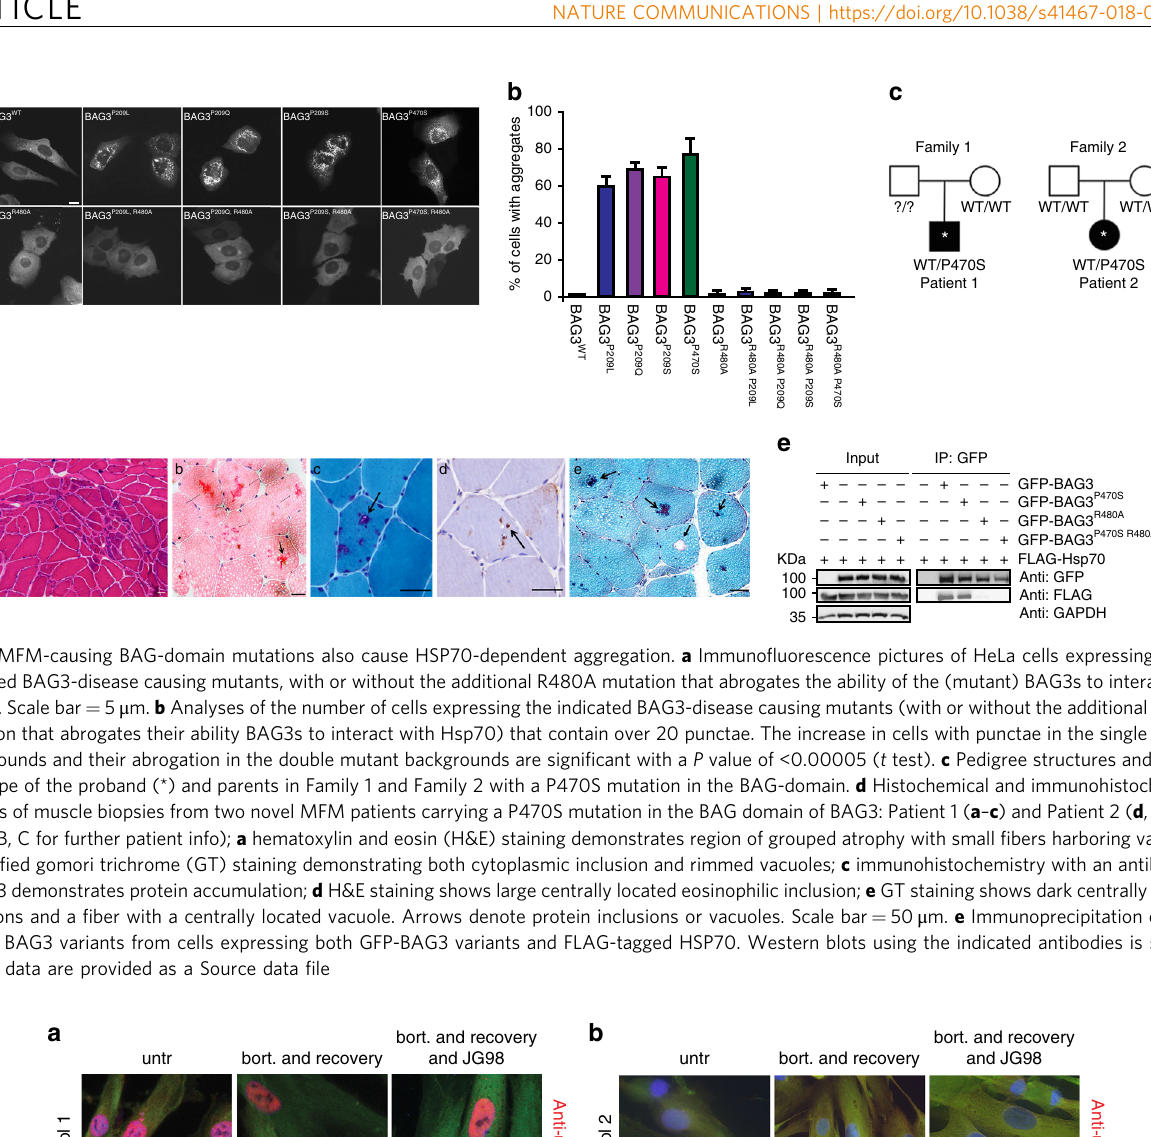
interactions (Fig. 5f) and reverts aggregates formation when the mutants are overexpressed (Fig. 5, Supplementary Figure 4). As predicted, this treatment indeed reduced the frequency of per- sistent BAG3 punctae in the lines from both BAG3 P209L and BAG P470S carriers (Fig. 9a, b). This con fi rms that they cause aggregation via similar mechanisms and imply that pharmaceu- tically targeting the Hsp70 – Bag3 interaction could be a fi rst therapeutic strategy for patients carrying P209L/Q/S or P470S substitutions. NATURE COMMUNICATIONS| (2018) 9:5342